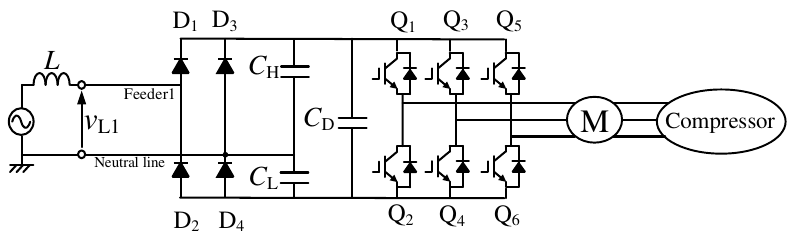
Figure 3. Single-phase voltage doubler rectifier for air conditioner